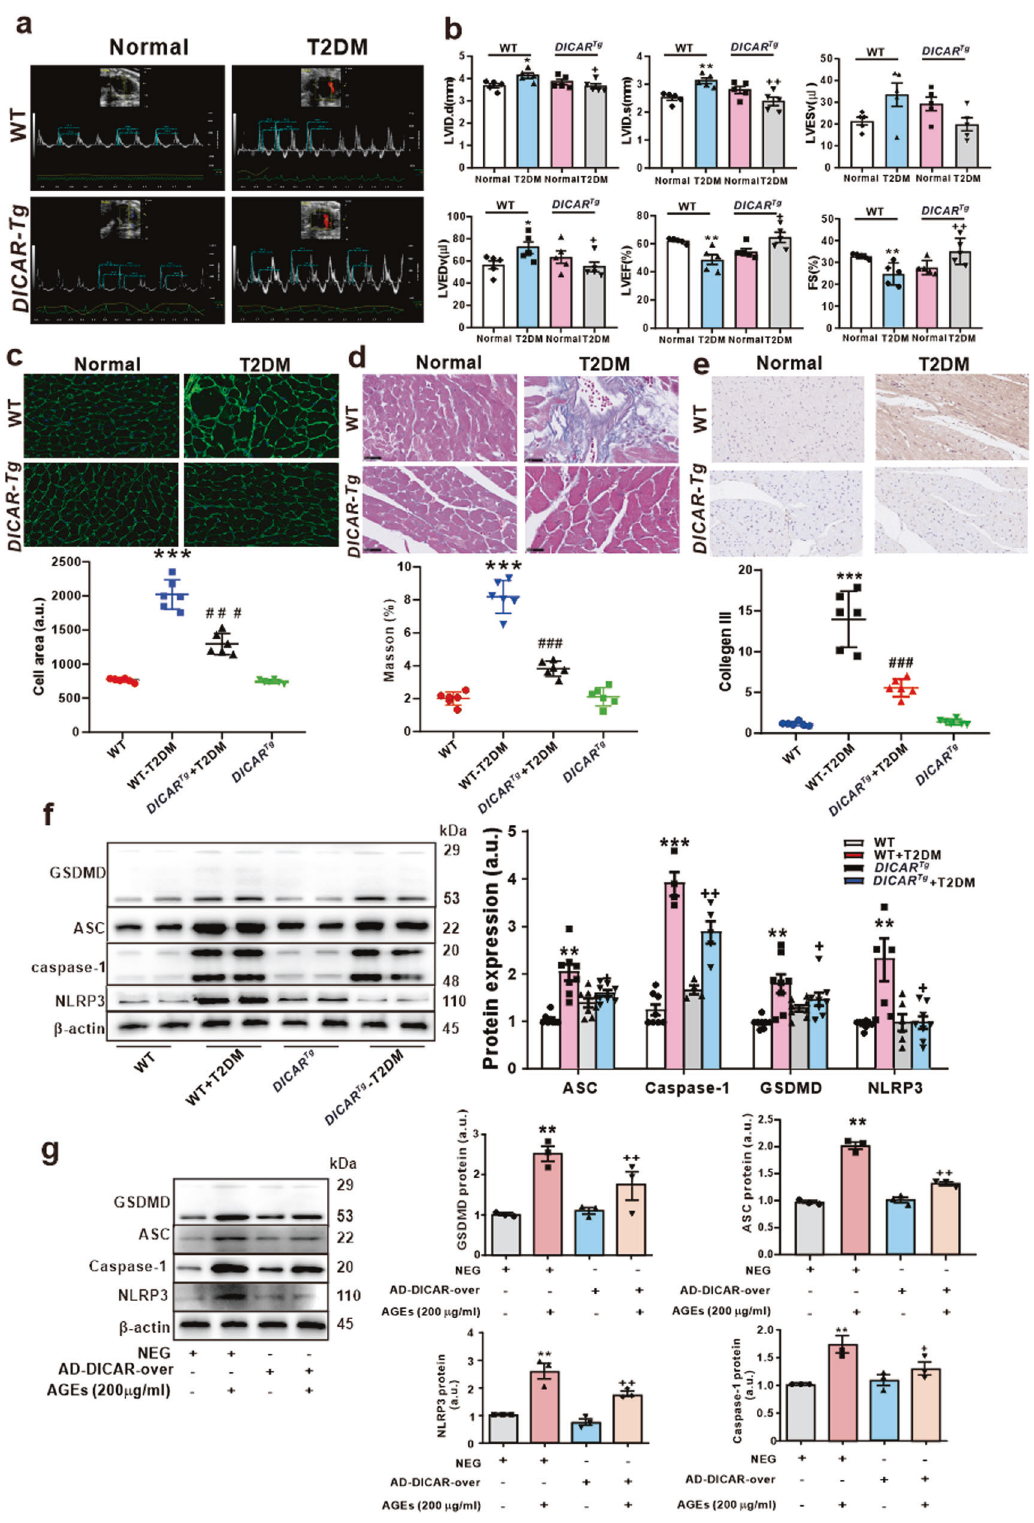
Fig. 3 Gain of DICAR function ameliorates T2DM-induced heart function in DICAR Tg mouse. a Representative echocardiography images of DICAR Tg mouse. b The DICAR overexpression ameliorates heart functions, including stroke volume (SV), ejection fraction (EF), left ventricular end-diastolic dimension (LVEDD), left ventricular end-diastolic volume (LVEDV), cardiac output (CO), and fractional shortening (FS). c The DICAR overexpression decreased the cardiomyocytes area detected by wheat germ agglutinin (WGA) staining. d Collagen deposition detected by Masson staining. e Collagen III expression detected by IHC. f In the DICAR Tg mouse, the DICAR overexpression inhibited the pyroptosis of heart tissue induced by T2DM that detected by the GSDMD, ASC, IL-1 β , and NLRP3 protein expression. Data are represented as mean ± SEM. ** P < 0.01 vs. Normal, ++ P < 0.01 vs. Normal + T2DM, n = 8. g Adenovirus (AD)-DICAR infected HL-1 cells inhibited the pyroptosis induced by AGEs (200 µg/mL). Data are represented as mean ± SEM. ** P < 0.01 vs . NEG, ++ P < 0.01 vs. AD-DICAR-over, n = 4 Signal Transduction and Targeted Therapy (2023)